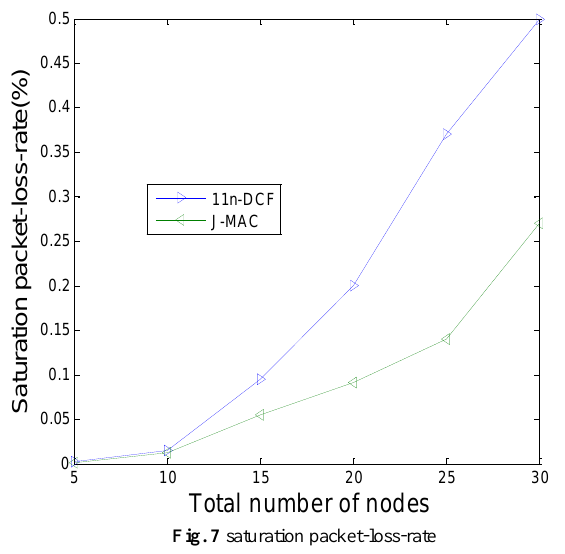
Fig. 7 saturation